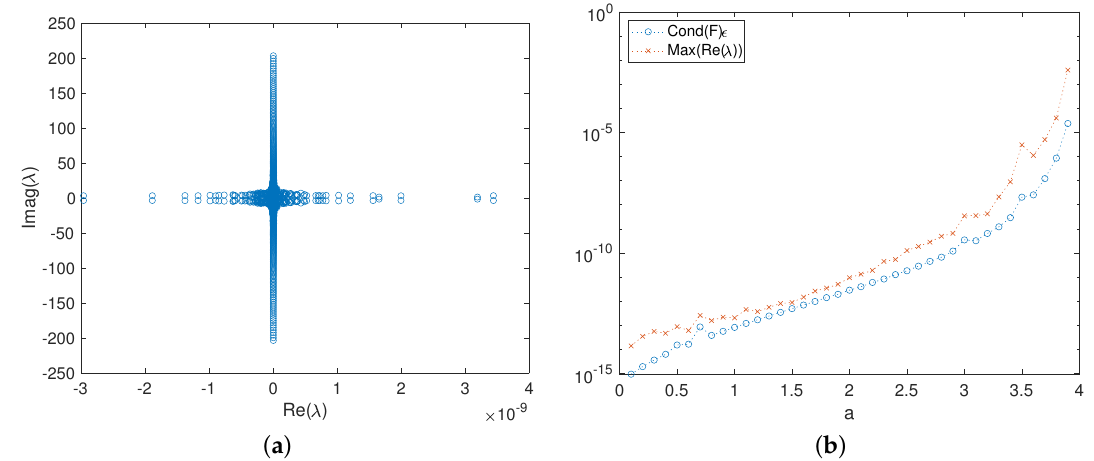
Figure 4. ( a ) The spectrum of the linear operator used for the evolution depicted in Figure 2. ( b ) The condition number and the maximally real eigenvalue of the approximation of the linear operator as a function of the step-size parameter “ a ” in Equation (3), marked with xs, is compared to the condition number of eigenvector matrix, F , of the RBF-FD differentiation matrix times the machine precision, (cid:101) , marked with